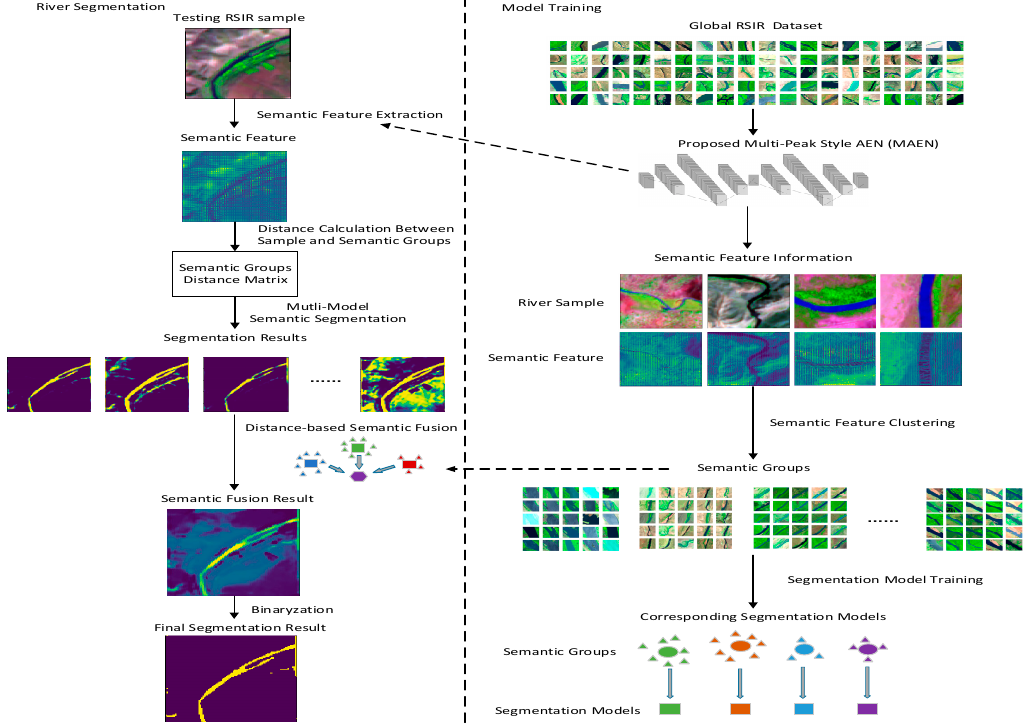
Figure 6. The proposed semantic fusion structure (the structure contains a model training process and river segmentation process, including sematic feature extraction and sematic segmentation fusion methods).